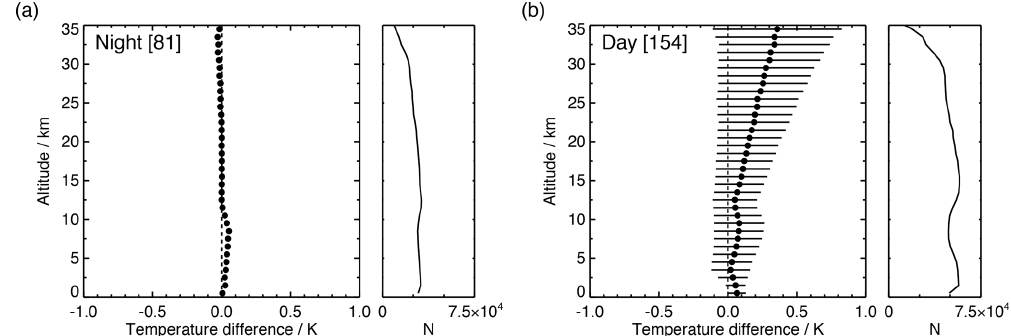
Figure 20. Comparison of the GRUAN data product (GDP) and Vaisala product (EDT) for RS41 temperature radiosoundings performed in Lindenberg between 2014 and 2021. Data were taken from radiosoundings performed at nighttime ( a , solar-elevation angle α s < − 10 ◦ , N = 81) and daytime ( b , α s > 10 ◦ , N = 154). The main graphs show the median of T GDP − T EDT (solid dots) versus altitude for 1000m wide altitude bins, and the side plots show the number of data points in each altitude bin. The horizontal bars represent the uncertainty ( k = 2) that is composed of the correlated and uncorrelated uncertainties of both data products. The correlated uncertainties for nighttime measurements are absent, because no radiation correction is